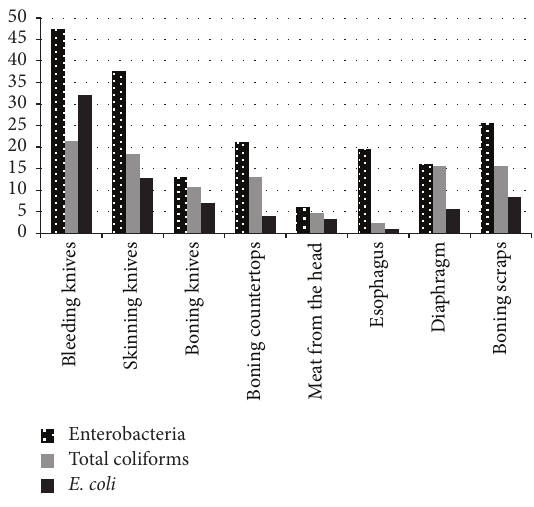
Figure 1: Count averages (CFU) for Enterobacteria, total coliforms, and E. coli in equipment, utensils, and comminuted beef produced in a slaughterhouse refrigerator in the state of Mato Grosso,